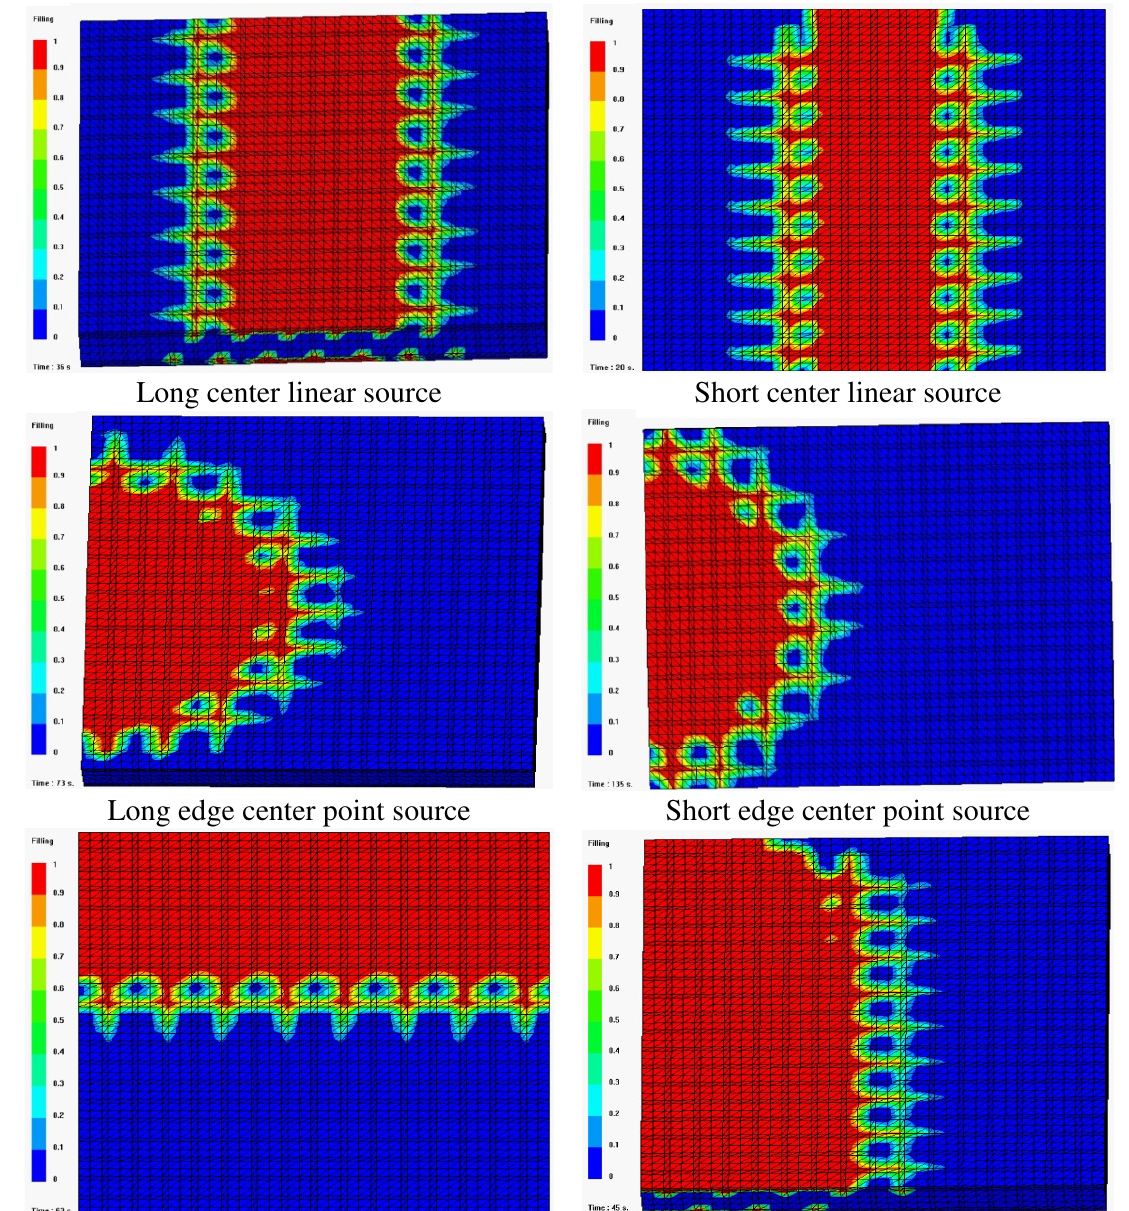
Figure 4. Sketch map of the resin flow front of different resin source